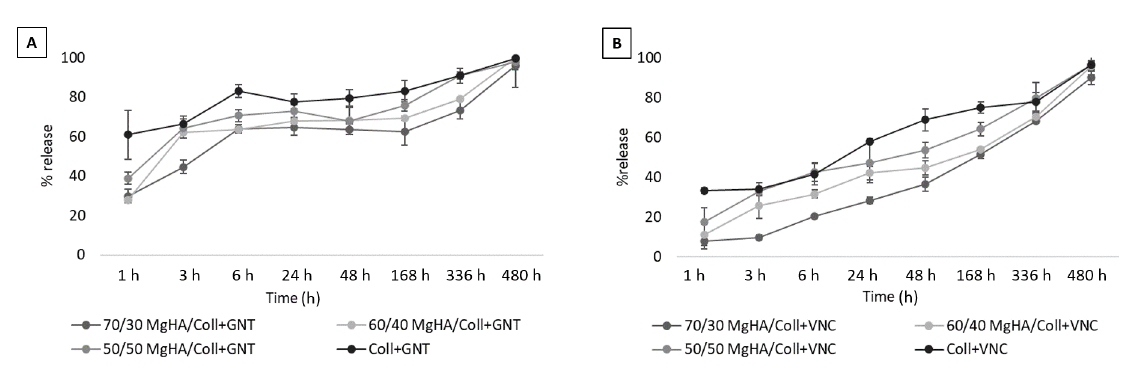
Figure 4. Gentamicin and vancomycin release profiles at 37 ◦ C and PBS, from all scaffold compositions loaded with ( A ) 2.5 mg of gentamicin and ( B ) 5.0 mg of vancomycin, recorded from time zero to twenty days.